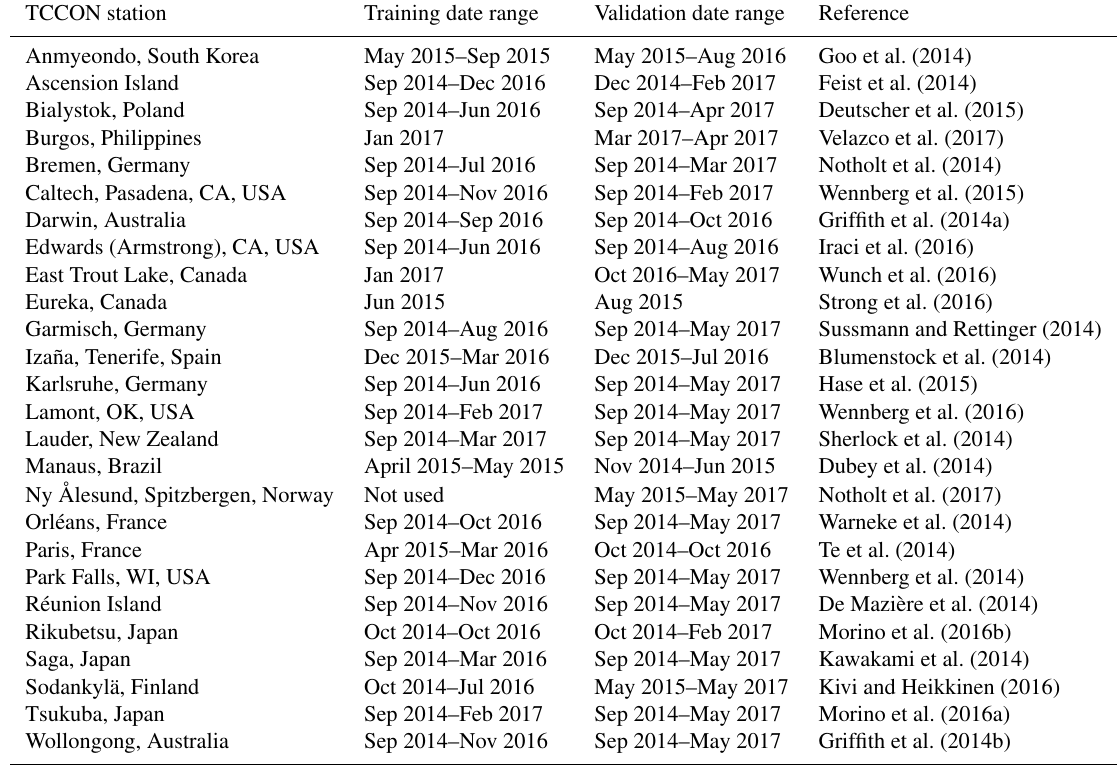
Table 7. TCCON stations used in this work.